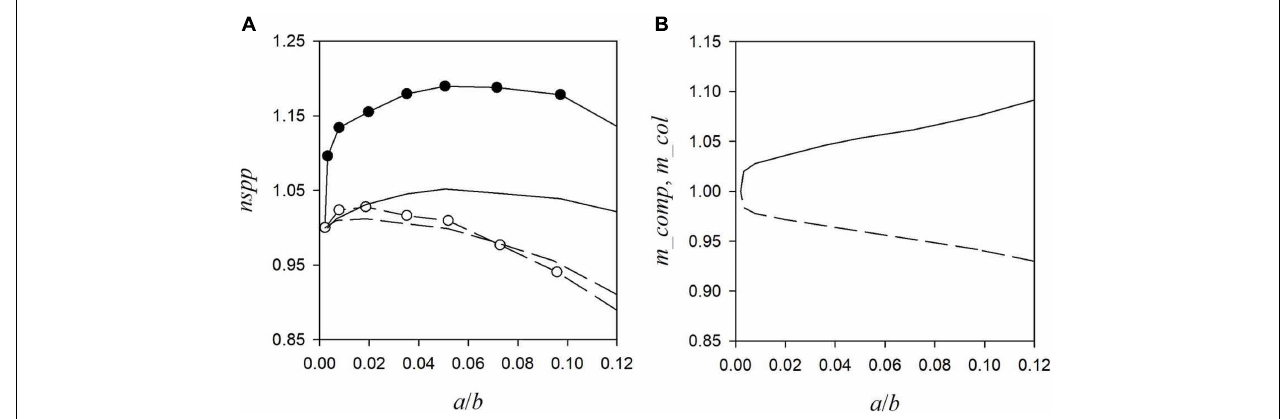
FIGURE 2 | (A) Shows the expected number of extant species nspp as a function of the ratio of agglomeration bonus and base payment ( a / b ) for four model parameter combinations, defined in section Sensitivity Analysis by the variations in the competition strengths and colonisation rates sd k and sd c and the mean dispersal range m d . Lines without and with symbols: sd c = 0.1 and sd c = 0.3; solid and dashed lines: m d = 2.5 and m d = 5.5; sd k = 0.4 (the results for sd k = 0.1 are similar: Supplementary Table D1 ). (B) Shows the mean competition strength m_comp (solid line) and colonisation rate, m_col (dotted line) of the extant species as functions of a / b , for sd k = 0.4, sd c = 0.3 and m d = 2.5 (the results for the other model parameter combinations are shown in Supplementary Table D1 ). All quantities are scaled relative to their values obtained at a / b =